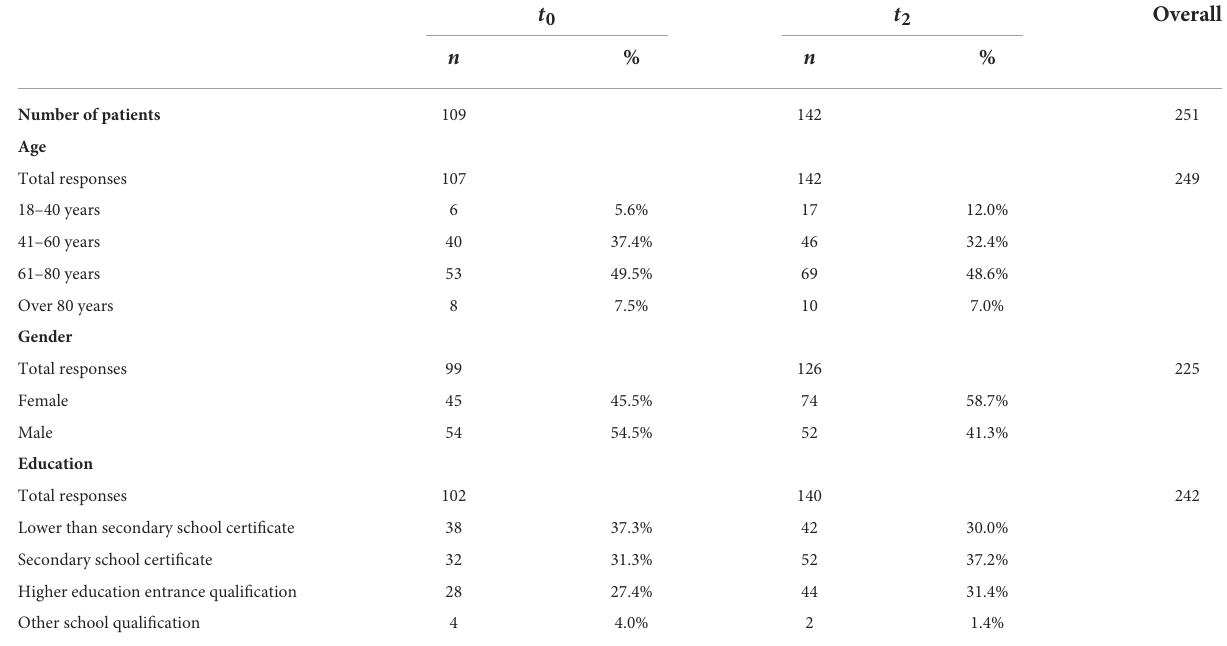
TABLE 1 Sample description.